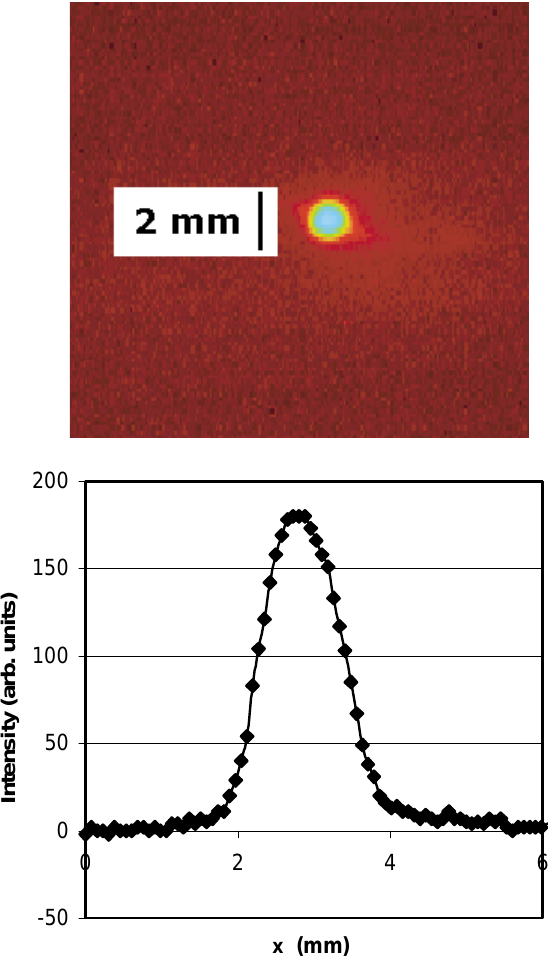
FIG. 8. (Color) Image of the 0.9 MeV electron beam (top) with Gaussian profile and 0.6 mm rms beam radius (bottom). The beam is imaged with a YAG crystal placed in the beam